Question: Is the quantity shown trending increasing or decreasing?
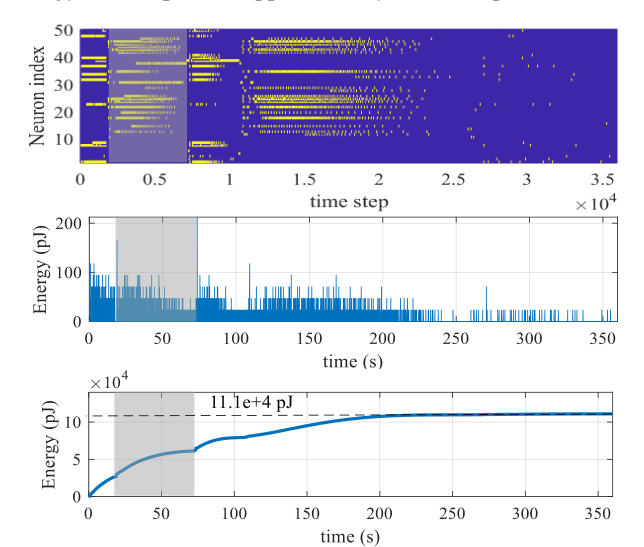
Answer: increasing